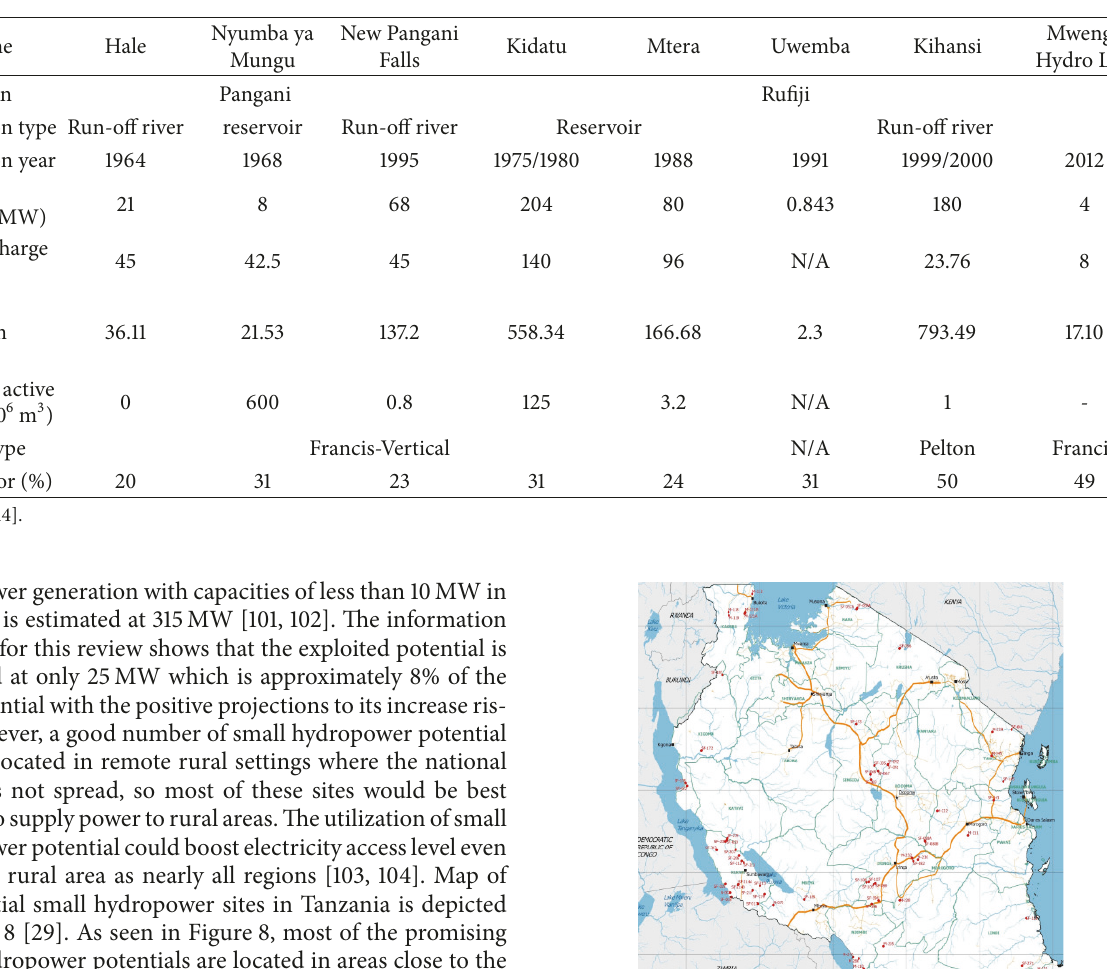
Table 3: Installed hydropower generation characteristics in Tanzania.